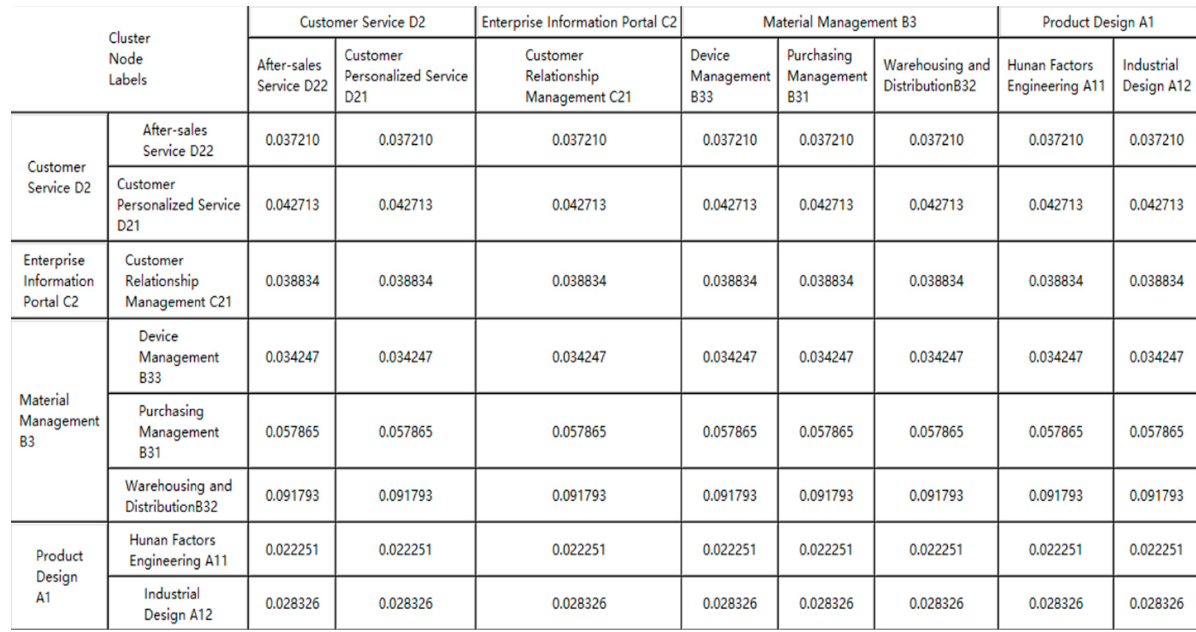
Figure 9. Limiting weighted hypermatrix derived from SD software (partial data).